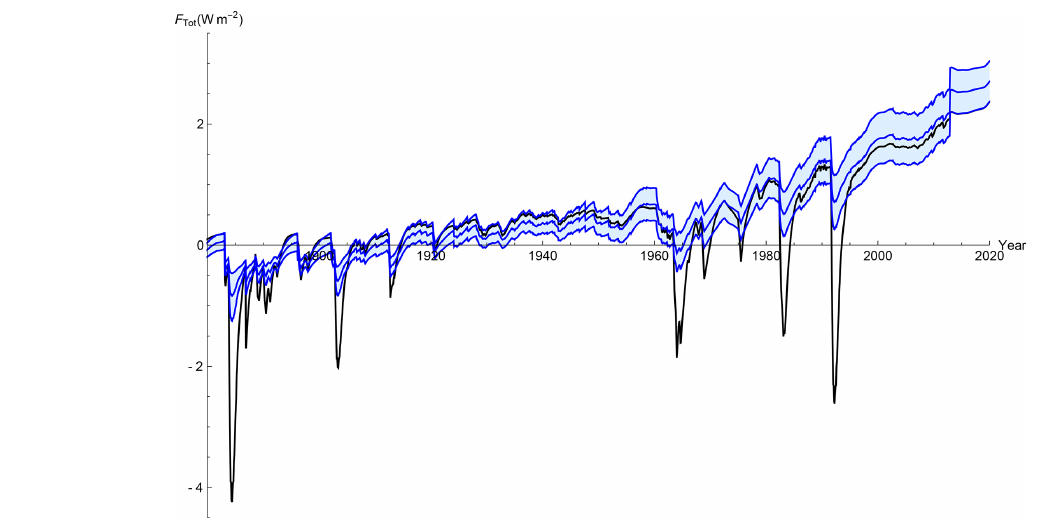
(black) compared to the adjusted forcing, RCP